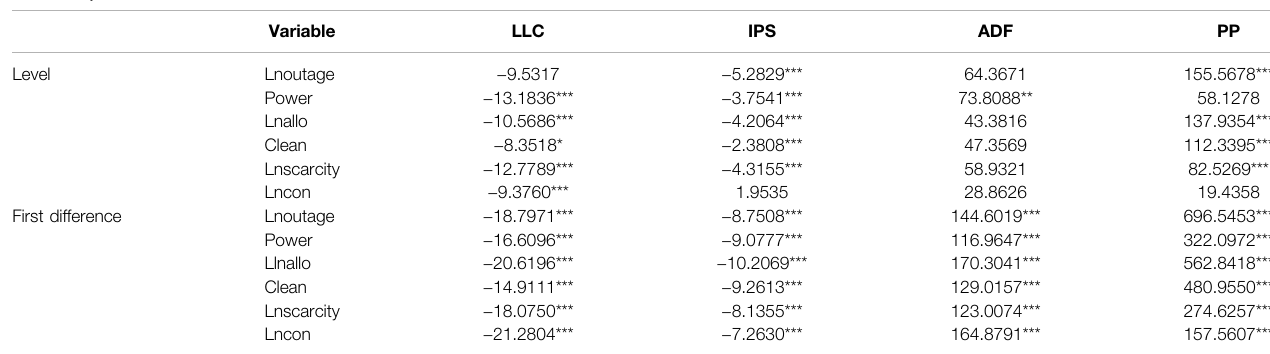
TABLE 2 | Results of unit root